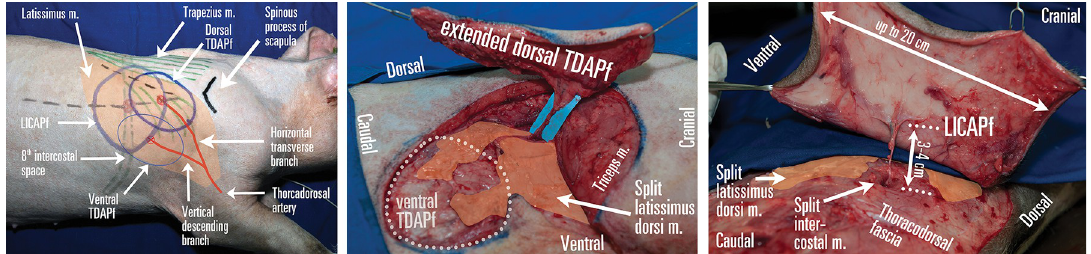
Fig 2. Thoracodorsal artery perforator flap (TDAPf) and lateral intercostal artery perforator flap (LICAPf) planning in pigs. (A) TDAPf can be harvested with a dorsal or ventral skin paddle, based on either the horizontal transverse branch or the vertical descending thoracodorsal artery branch. In both cases, the flap extends in the territory irrigated by the lateral intercostal perforators, which pierce the latissimus dorsi on their way to the skin and can be mistaken for the TDA perforator. (B) An extended TDAPf harvested by combining the dorsal and ventral TDAP flap paddles. The latissimus dorsi muscle has been split to allow for a longer pedicle, which can be extended up to the thoracodorsal artery for a total length of 12–14 cm. (C) A large LICAPf can be harvested if no TDAPf is planned on the same hemitorax. Both latissimus dorsi and intercostal muscles are split to allow for a longer pedicle. Republished from personal archive under a CC BY license, with permission from Dr. Nistor Alexandru, original copyright 2016.